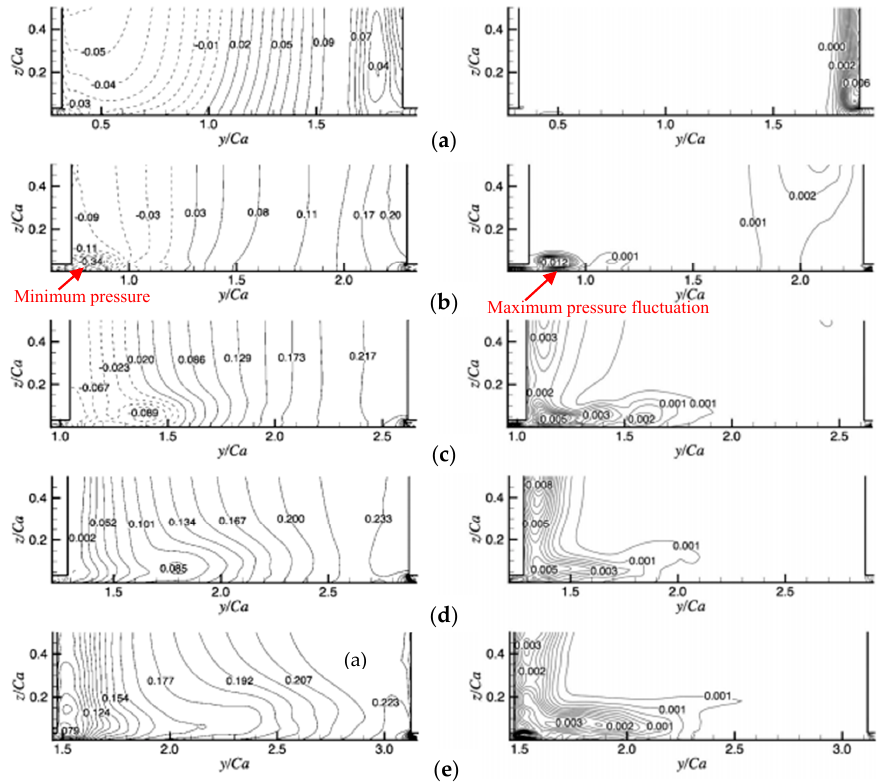
Figure 15. Distribution of mean pressure and pressure fluctuations: ( a ) 10% chord; ( b ) 30% chord; ( c ) 50% chord; ( d ) 70% chord; and ( e ) 90% chord [41].